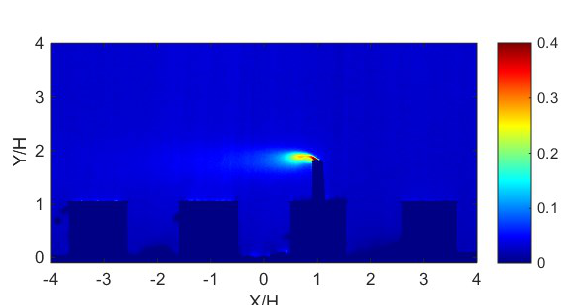
Fig. 14. Mean non- dimensional concentration C/C 0 field (C 0 is the mean concentration measured at the top of the chimneystack) for pitched roof and a chimneystack (on the upstream pitch) with h/H = 0.75; the flow moves from the right to the left.